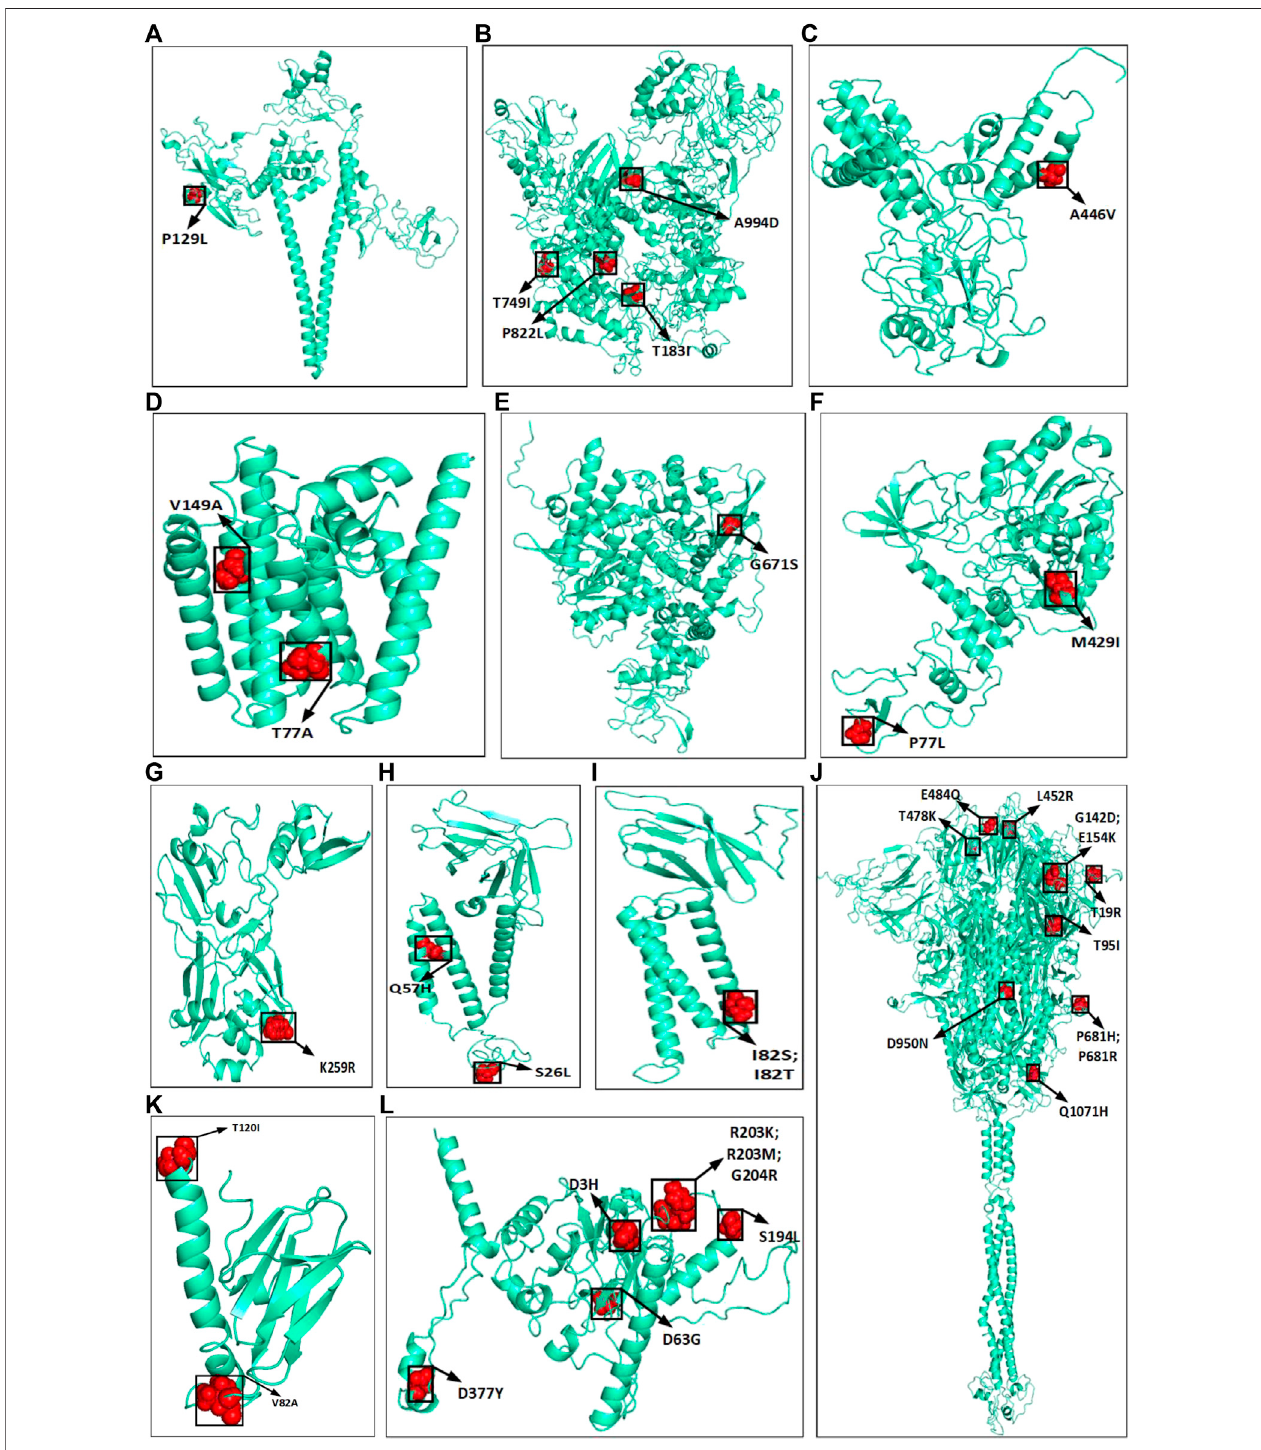
FIGURE4| Highlightedaminoacidchangesintheproteinstructuresforthenon-synonymoussubstitutionsormissensehotspotmutationsforIndianSARS-CoV-2 genomes in (A) NSP2, (B) NSP3, (C) NSP4, (D) NSP6, (E) RdRp, (F) helicase, (G) endoRNAse, (H) ORF3a, (I) Membrane, (J) Spike, (K) ORF7a, and (L) Nucleocapsid.